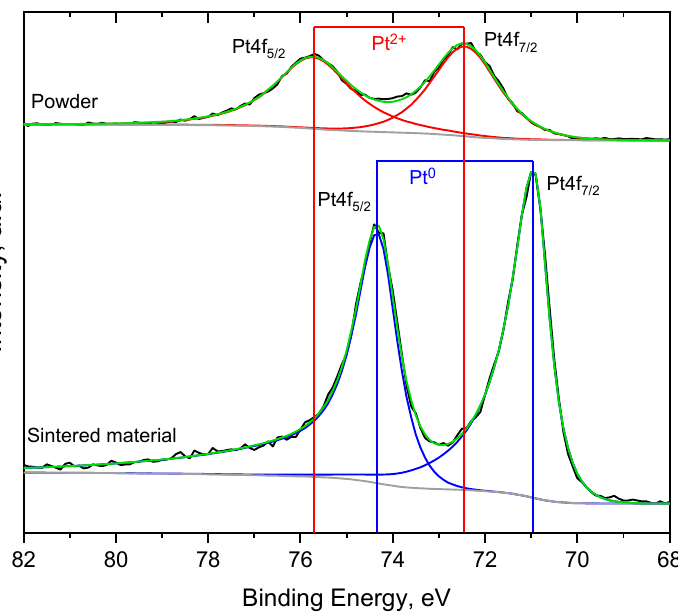
Figure 2. X-ray photoemission spectroscopy (XPS) spectra corresponding to the Pt4f core level region of the powder and sintered material. The spectra were acquired by using Al K α radiation.